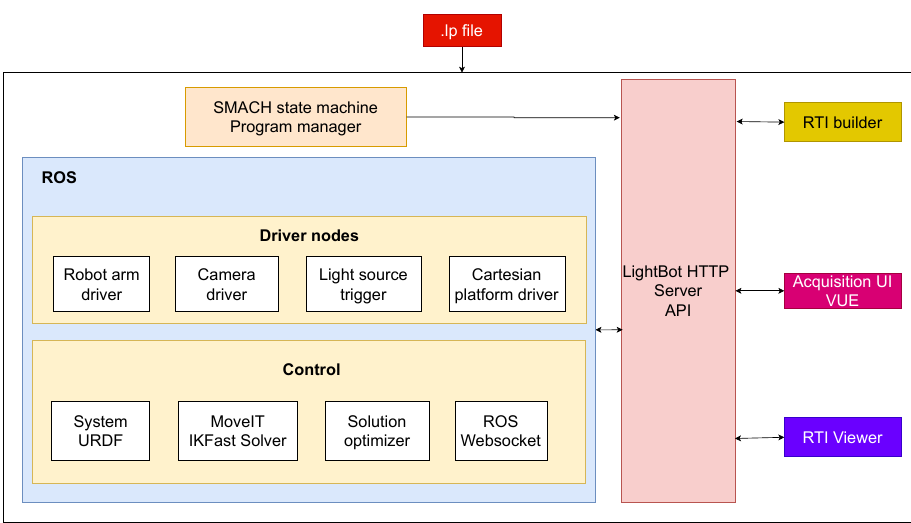
Figure 3. System architecture of the